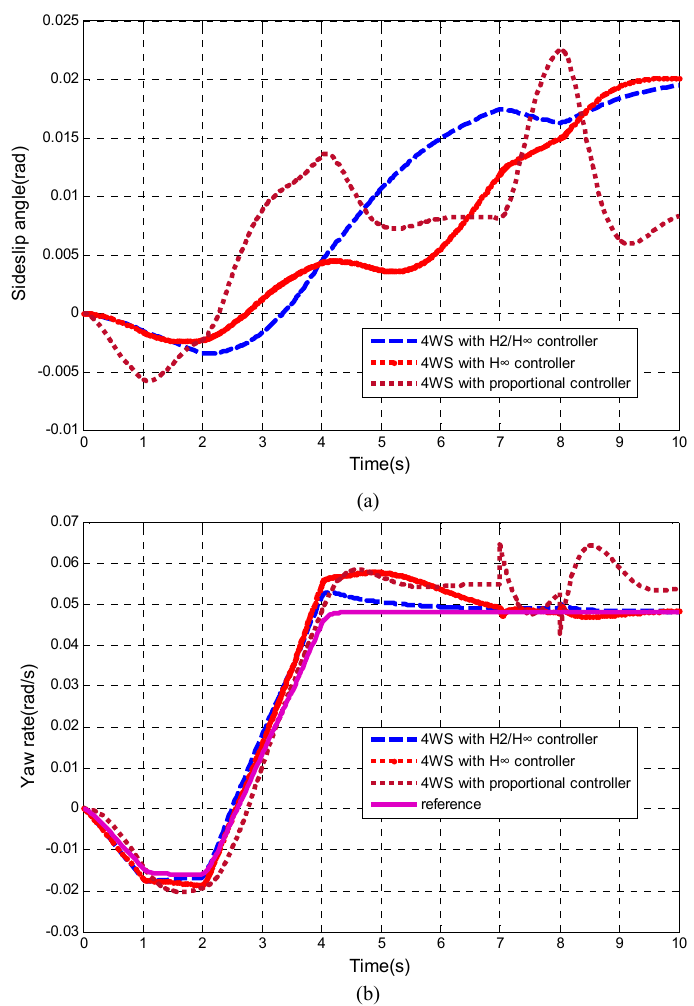
Figure 25. The fishhook maneuver simulation results under disturbances: ( a ) sideslip angle response; ( b ) yaw rate response.